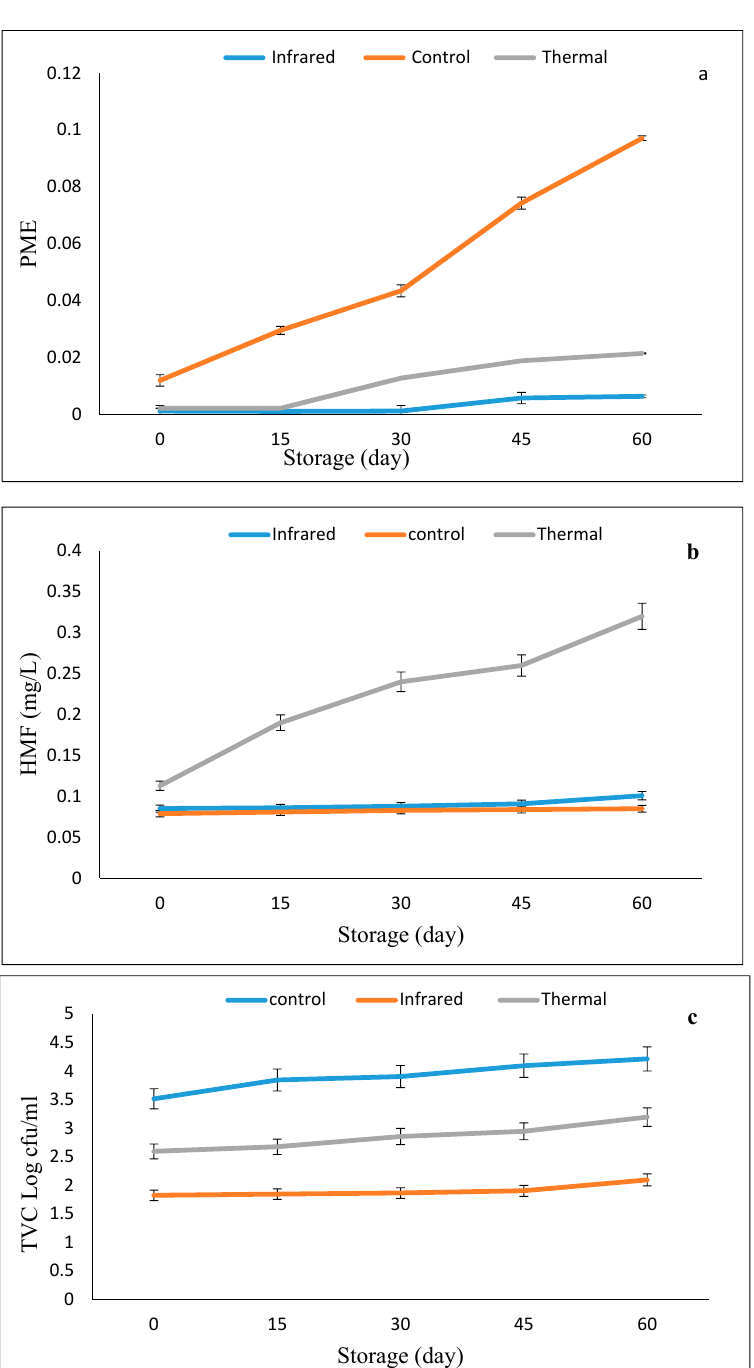
00.511.522.533.544.5 Figure 4. The ( a ) pectinmethylesterase activity (PME) activity, ( b ) hydroxymethylfurfural (HMF) content, and ( c ) total plate count bacteria (log cfu/mL) of the infrared treated juice samples, the thermally treated samples (conventional), and the control sample during storage for 60 days at a temperature of 5 °C. There was no increase in the effectiveness of the enzyme for the samples treated with infrared radiation for 30 days of storage at a temperature of 5 °C, while the effectiveness of the enzyme began to increase significantly and for periods of 30 to 60 days of storage at a temperature of 5 °C. Previous studies indicated the presence of heat-resistant parts that led to a decrease in the inhibition trend of the enzyme with the advancement of stor- age periods. The inhibition of the enzyme activity is also influenced by the heat treatment conditions such as the heating method used, time, and temperature. The results of the statistical analysis showed that the activity of the enzyme in the infrared-treated samples was significantly lower ( p < 0.05) compared to the control sample and the thermally treated samples. In addition, the results indicated the presence of significant differences ( p < 0.05) between the thermally treated samples and the control sample in relation to lower the enzyme activity of the thermally treated samples. This result confirms that higher temperatures cause more changes in the structure of this enzyme by breaking down the hydrogen bonds and thus reducing the activity of the enzyme [49]. 3.6. Determination of Hydroxymethylfurfural (HMF) Figure 4b shows the hydroxymethylfurfural content of juice samples stored at 5 °C for a period of 60 days. The results obtained show that the quantity of HMF ranged be- tween (0.0852–0.101) mg/L for juice samples treated with infrared radiation, while the quantity of HMF ranged from (fresh) control samples and the thermally treated samples (0.079–0.085) and (0.0113–0.32) mg/L, respectively. It was noted from the results that the amount of HMF in all juice samples gradually increased during the process of cold storage at a temperature of 5 °C for 60 days. These results are in agreement with Randhawa et al. [50] who indicated that the main reason for the accumulation of HMF during storage may be due to the degradation of ascorbic acid, as was observed by other scientists in citrus juice concentrates [50,51]. The results of the statistical analysis of the sample content of HMF showed that there was a significant difference ( p < 0.05) between the infrared-treated juice samples and the thermal juice samples during storage for 60 days at a temperature of 5 °C, while the sta- tistical analysis results showed no significant difference ( p > 0.05) between the infrared treated juice samples and the (fresh) control sample. Moreover, the results of the statistical analysis indicated that there was a significant difference ( p < 0.05) between the thermally